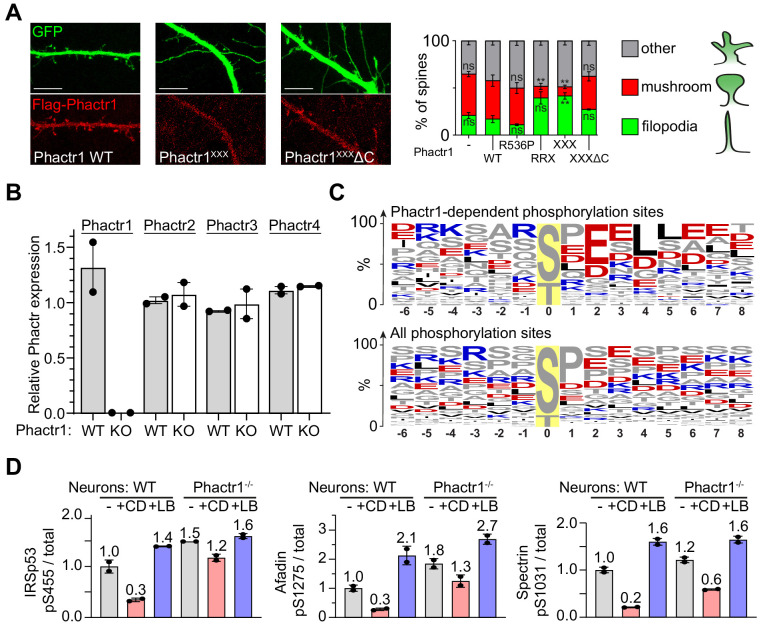
Neuronal substrates of the Phactr1/PP1 complex.(A) Rat hippocampal neurons were transfected with plasmids expressing Phactr1 derivatives and GFP, fixed after 1 day and their morphology scored blindly. Scale bar, 10 µm. Statistical significance was assessed by unpaired t-test with Welch's correction (means ± SEM, n = 3–5; **, p<0.01). (B) RT-PCR analysis shows that Phactr1 inactivation in brain does not affect expression of other Phactr family members, relative to Rps16 expression. (C) Wildtype and Phactr1-null neurons were treated with cytochalasin D (CD) and phosphorylation changes assessed by TMT phosphoproteomics. Top, amino acid frequency table of phosphopeptides showing a statistically significant dependence on Phactr1 (FDR < 0.2), bottom, amino acid frequency table of all phosphopeptides. (D) Quantitation of immunoblot data shown in Figure 3F. Lysates from Phactr1-null or wildtype neurons were left untreated or treated with CD or LB for 30' were analysed by immunoblotting with antibodies against IRSp53 pS455 (left); afadin pS1275 (centre); and spectrin αII pS1031 (right). See also Supplementary files 1 and 3.